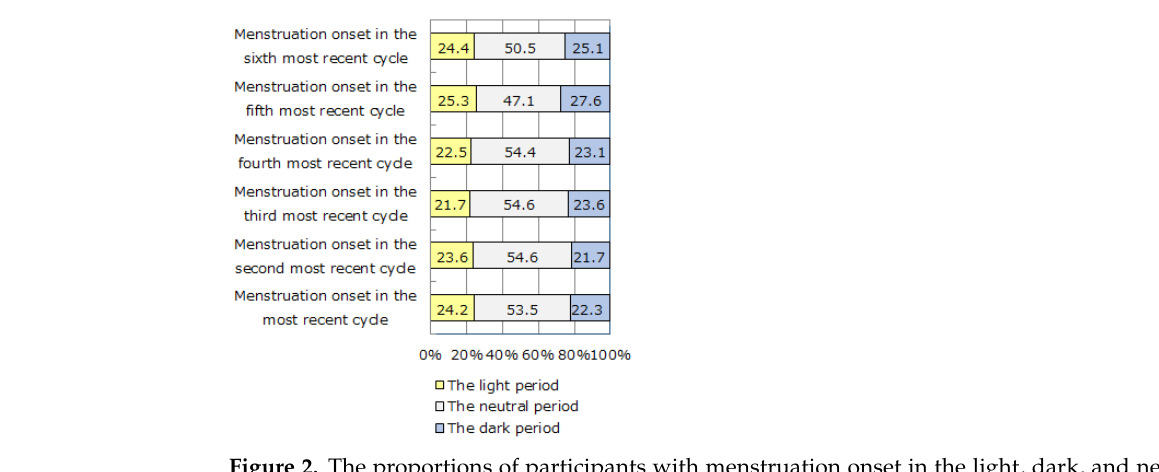
Figure 2. The proportions of participants with menstruation onset in the light, dark, and neutral periods in their six most recent menstrual cycles ( n = 529). There was no significant difference in the six menstrual cycles.